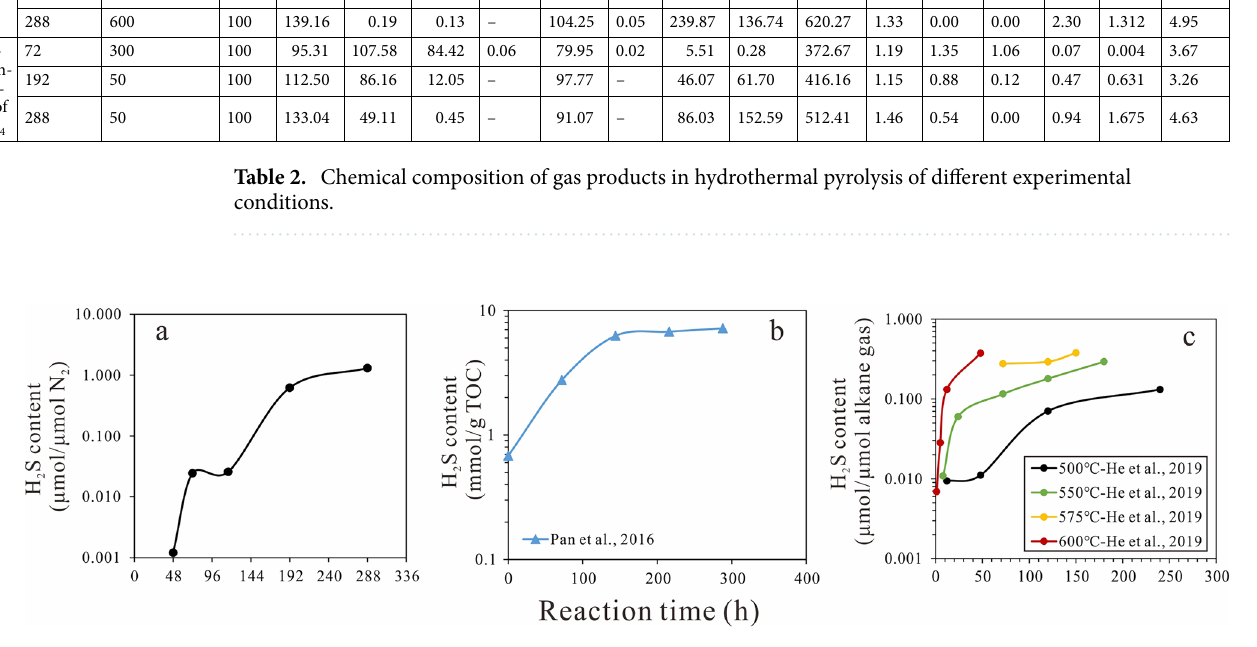
Figure 4. Variations in H 2 S contents with reaction time in this work ( a ), Ref. 25 ( b ), and Ref. 24 ( c